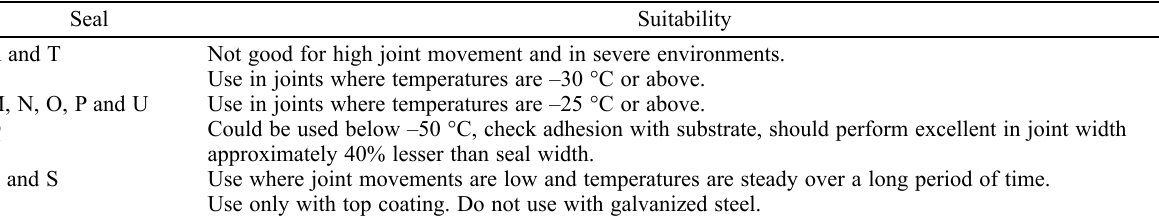
Table 6. Preliminary classification of preformed seals for specific